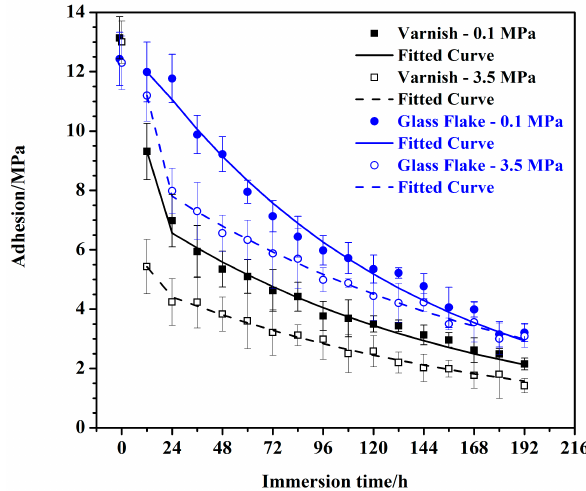
Figure 1. Changes of adhesion of the coating/steel systems under ordinary pressure (0.1 MPa) and hydrostatic pressure (3.5 MPa) (scatters: experimental data, solid and dash lines: fitting results of the grey models).